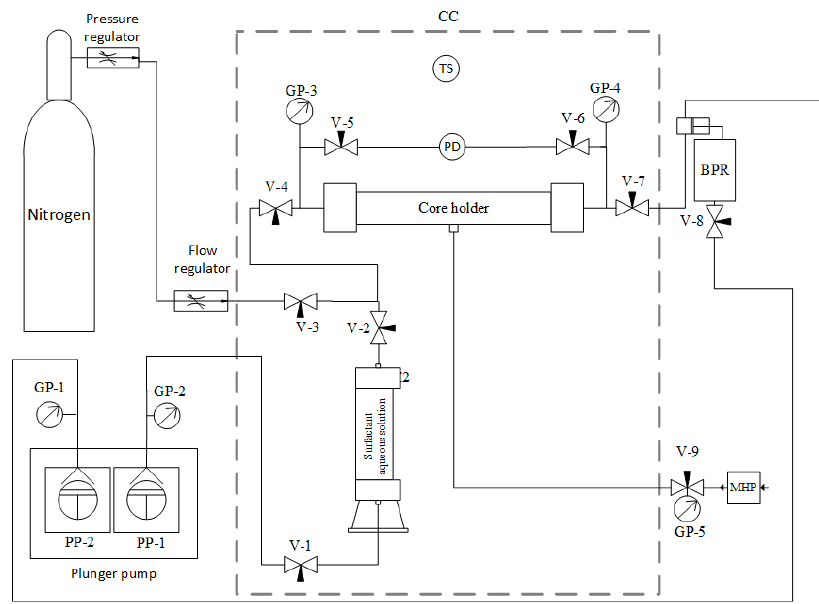
Figure 1. Scheme of the filtration setup: V—valves, GP—gauge pressure sensors, PD—pressure drop sensor, MHP–manual hydraulic pump, BPR—back pressure regulator, TS—temperature sensor, CC—climate chamber.